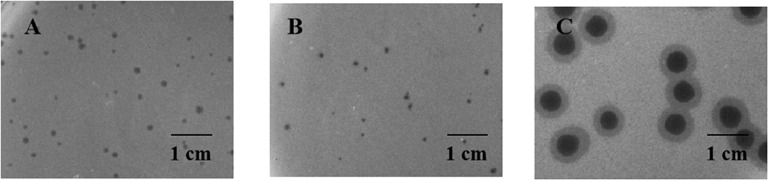
Plaque morphology of P545 (A), P539 (B), and P507 (C). Both P545 (A) and P539 (B) formed small clear and round plaques with a diameter of approximate 0.1 cm on double layer agar plate. P507 (C) formed big clear and round plaques with a diameter of approximately 0.5 cm surrounded by 0.15-cm enlarged haloes.